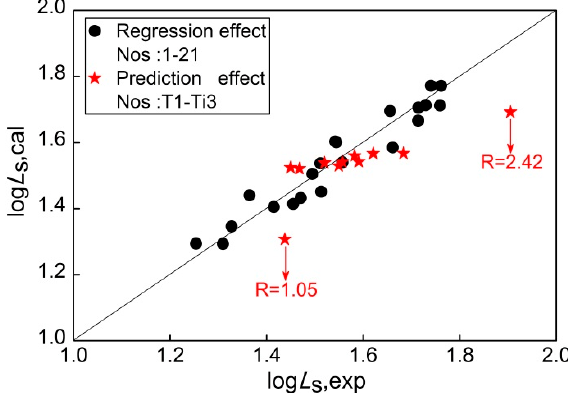
Figure 9. Comparison of experimental values and calculated values.